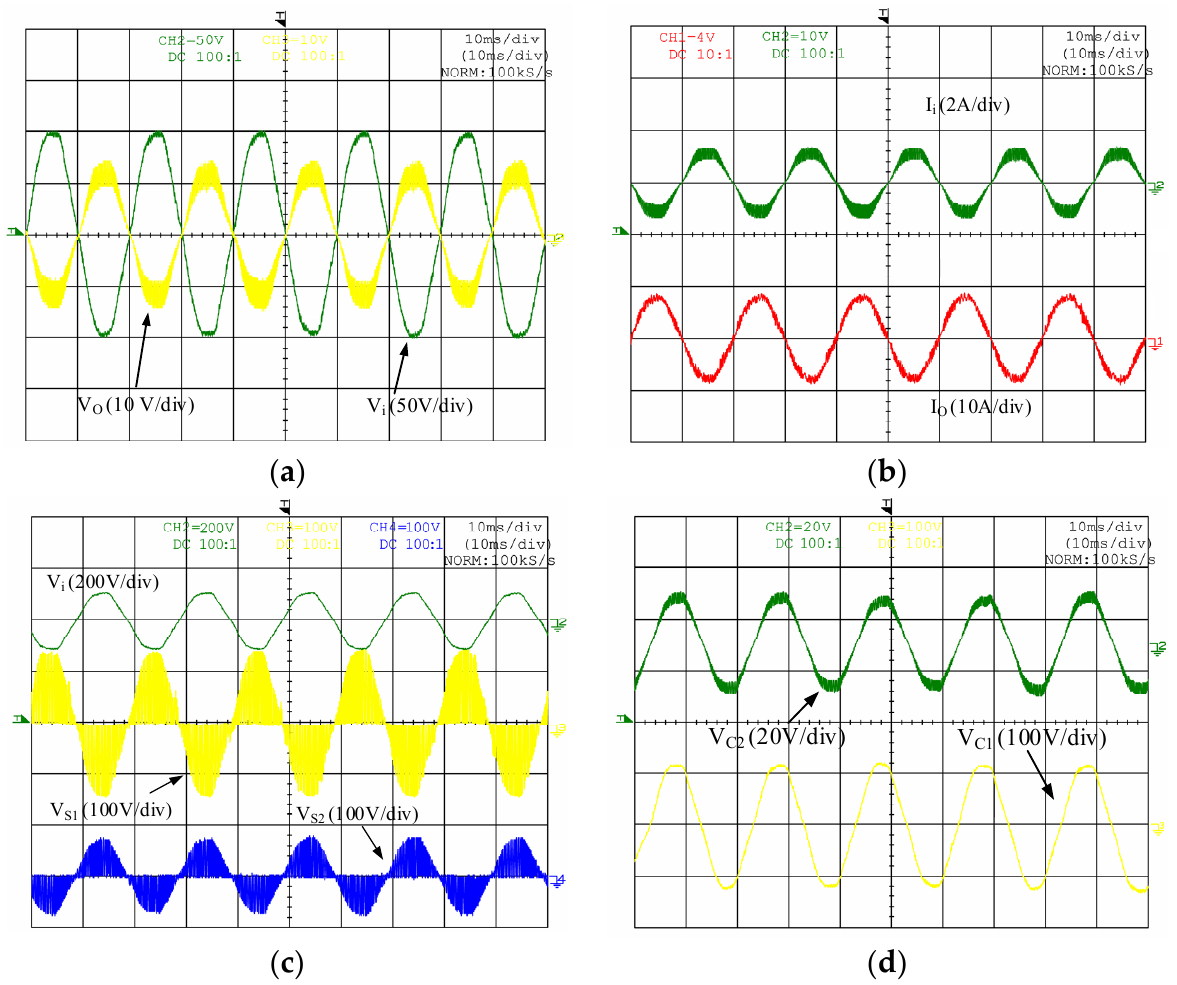
Figure 19. The experimental results of the proposed topology for Buck out-of-phase operating mode: ( a ) input and output voltage waveforms, ( b ) input and output current waveforms, ( c ) voltage stresses over power switches, and ( d ) capacitors’ voltages.